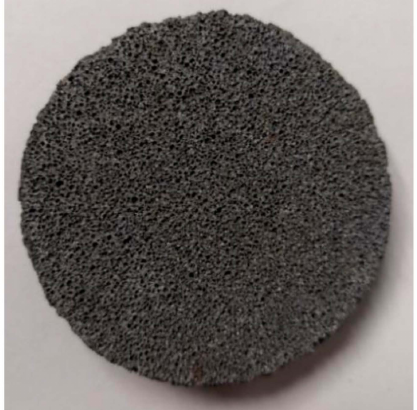
Figure 8. Microcellular foam aluminium material.